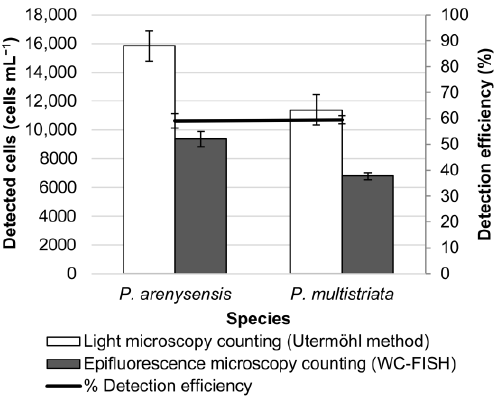
Figure 4. Simulated natural sample composed of two Pseudo-nitzschia species. Cell density (cells mL −1 ) was estimated before and after WC-FISH. Detection efficiency was calculated as FISH detectable cells (%) by the ratio between cells detected with rRNA FISH targeted probes vs. cells in culture before hybridization.